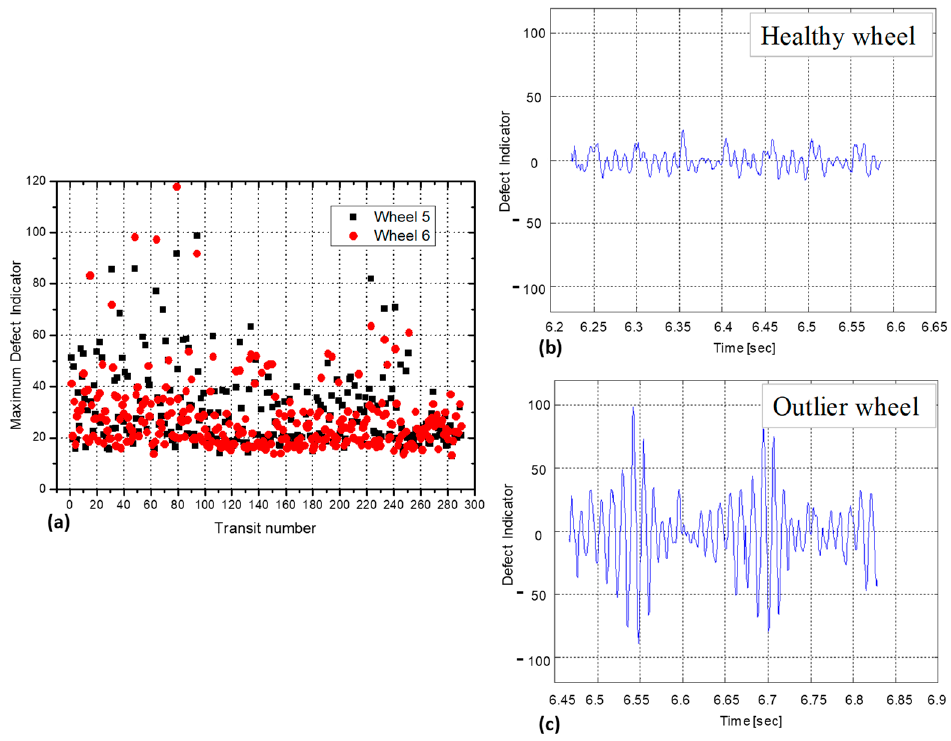
Figure 13. Maximum values of the defect indicator recorded in a Milan subway system ( a ) for 290 passenger trains, typical vibration pattern returned by a healthy ( b ) and outlier ( c ) wheel. Similar results are reported in [133].